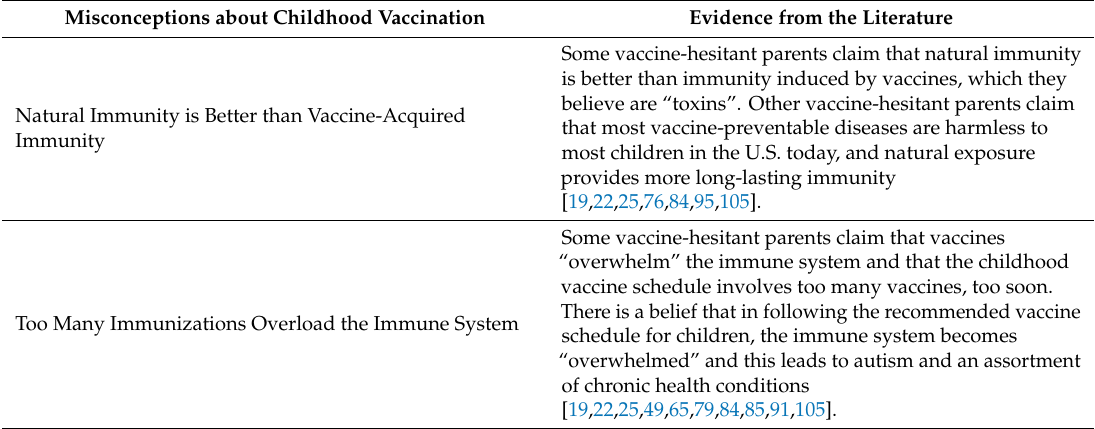
Table 8. Common misconceptions about childhood